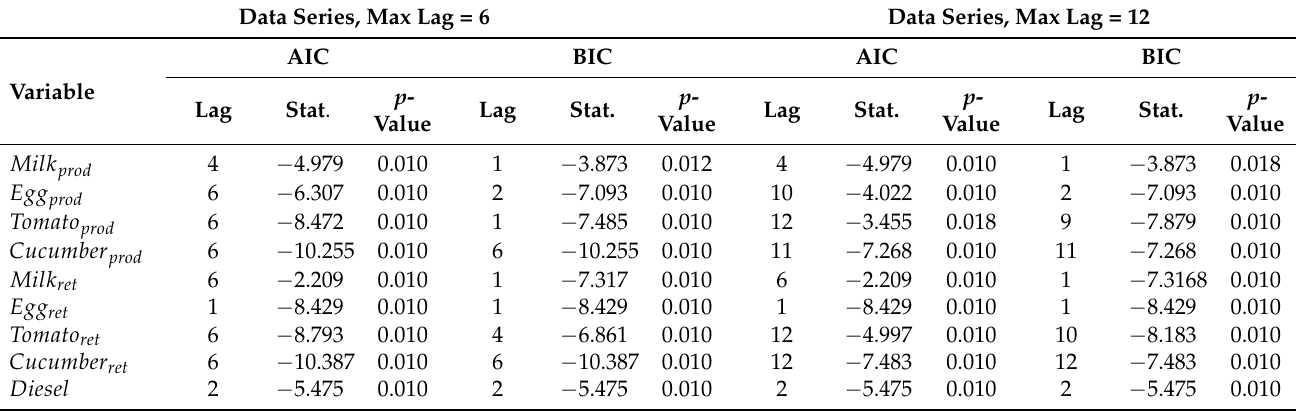
Table 4. Augmented Dickey–Fuller tests (first